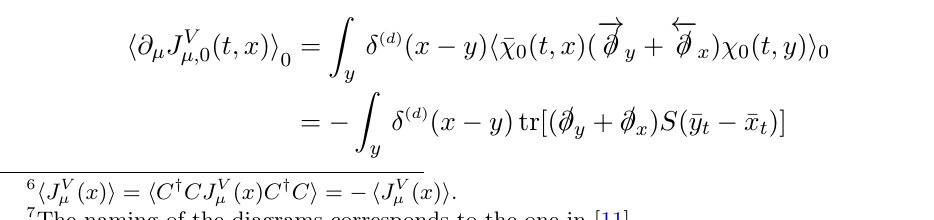
Figure 1. Diagrams that contribute to the 1-point correlator h @ (cid:22) J V and next-to-leading order (D02-D06). Notation is in appendix